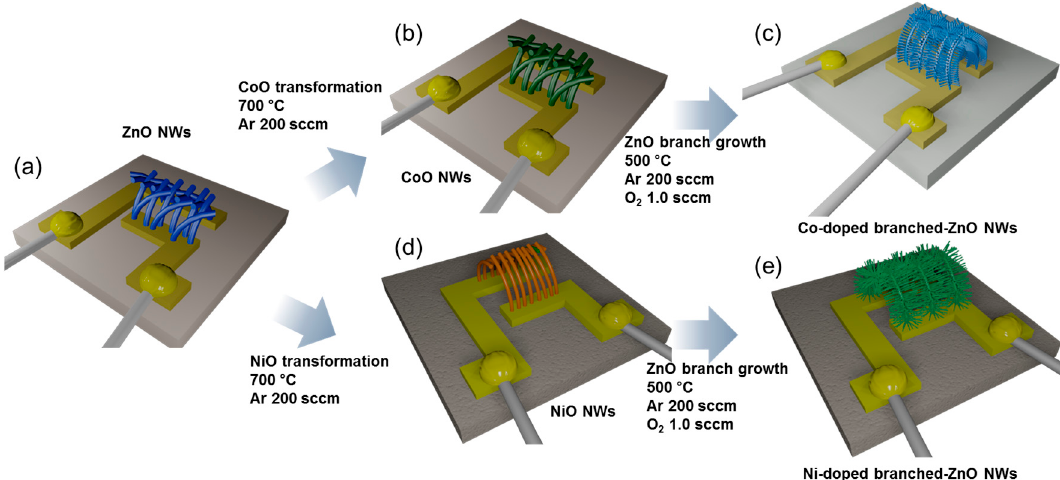
Figure 10. ( a ) Growth of ZnO NWs on alumina substrate with Au electrodes; ( b ) transformation of ZnO NWs into CoO NWs; ( c ) growth of Co-doped branched ZnO NWs from CoO NWs; ( d ) transformation of ZnO NWs into NiO NWs; ( e ) growth of Ni-doped ZnO NWs from NiO NWs. Reproduced from [131,137] with permission; ( a – c ) [137] Copyright (2014) American Chemical Society; ( d , e ) [131] Copyright (2015) Elsevier.